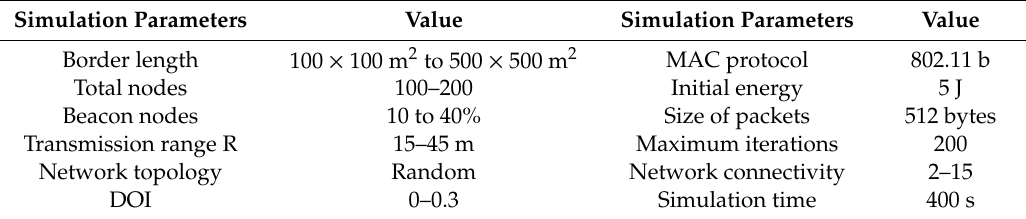
Figure 6. Deployment of sensor nodes. Table 4. Simulation parameters. Media access control (MAC).